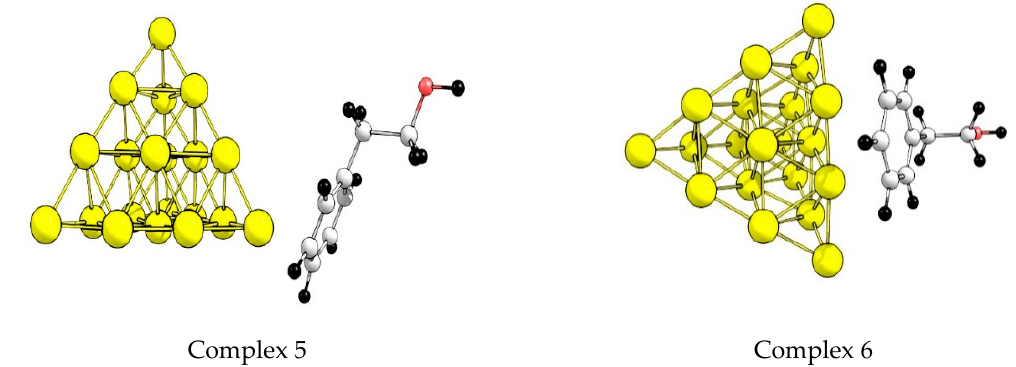
Figure 6. Optimized structures of phenylethanol-Au 20 complexes (coordination by C 6 H 5 fragment).